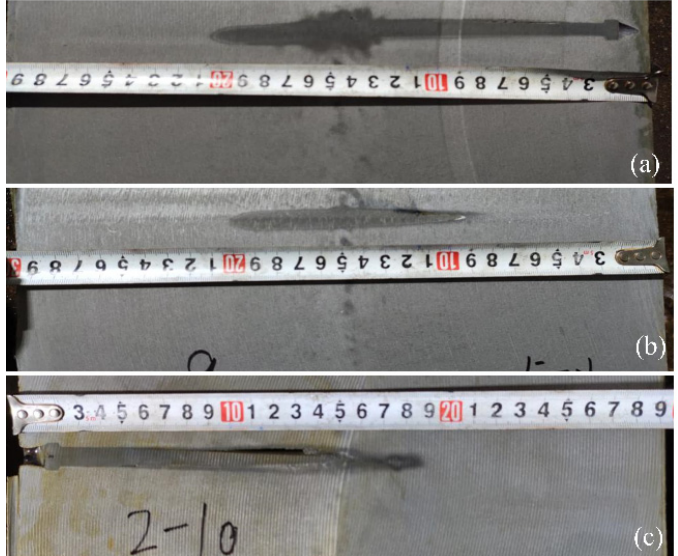
Figure 4. Photographs of sulfur printing samples for nail shooting experiments on S-4 steel: ( a ) The end of segment 8; ( b ) the end of segment 9; ( c ) the end of segment 10.